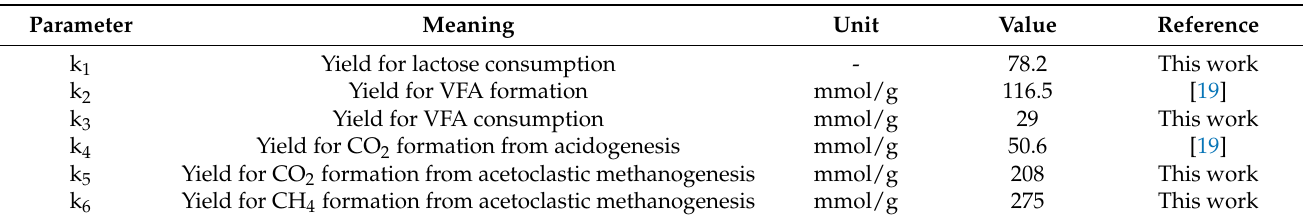
Table 5. Value of the yield parameters referred to the Anaerobic Digestion mode of the